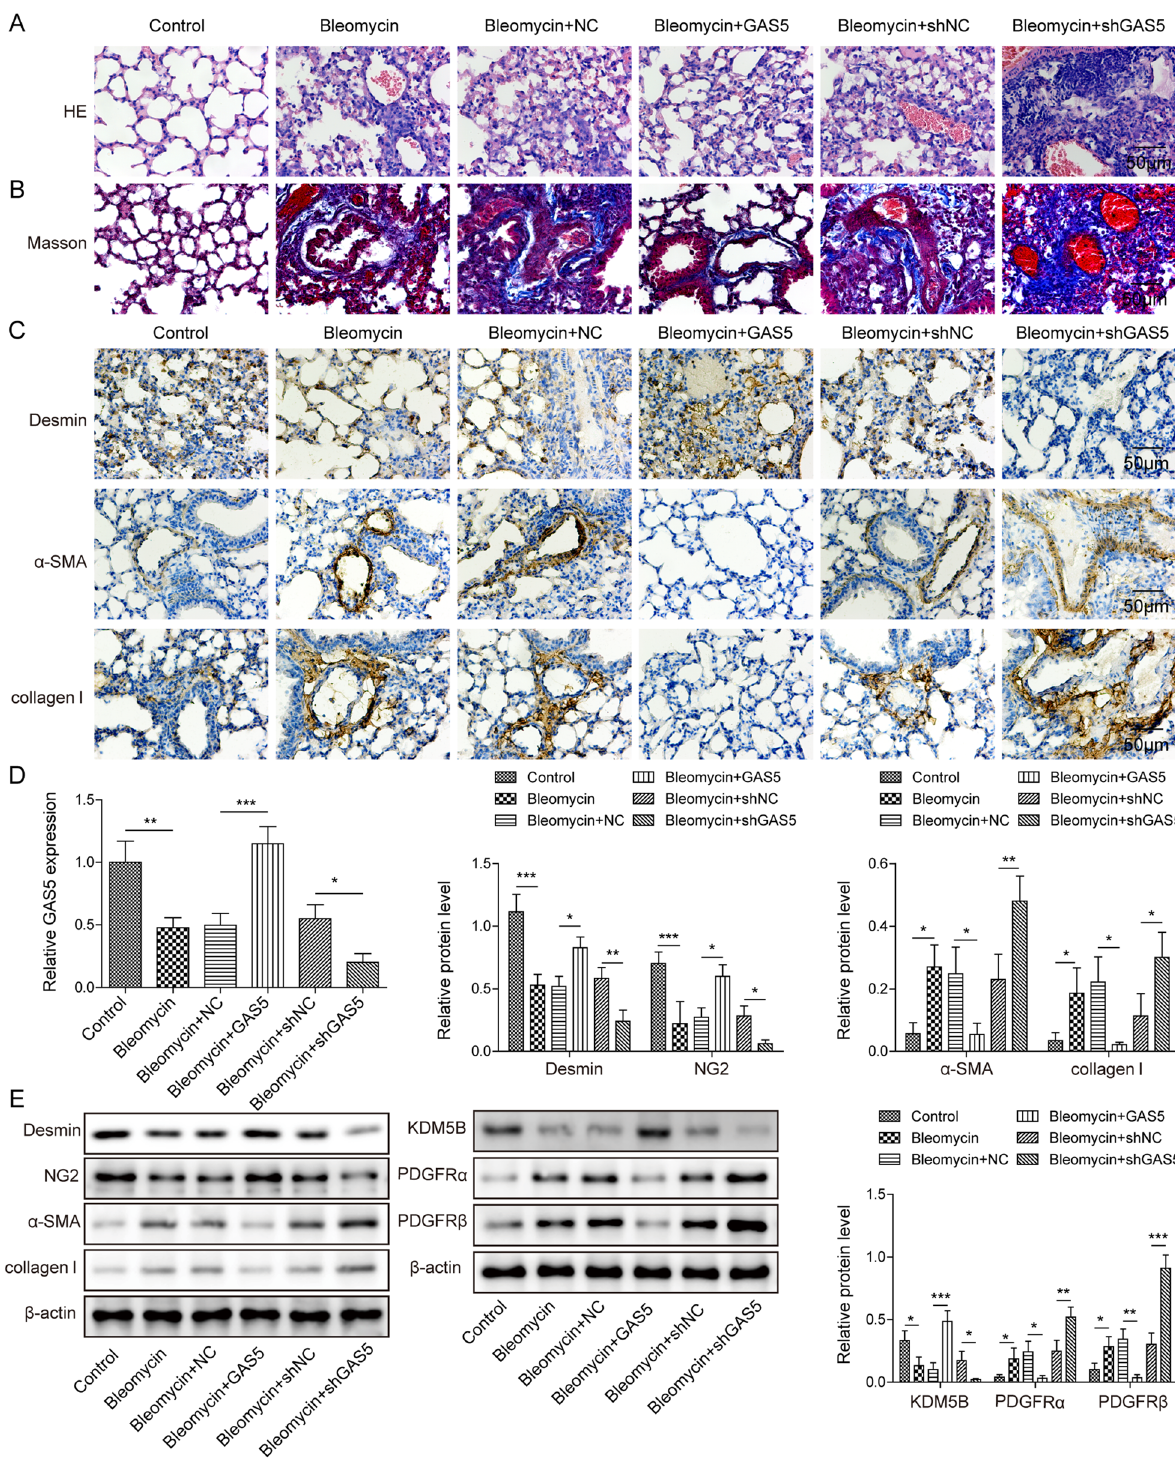
Fig. 8 GAS5 inhibited pulmonary fibrosis in the mouse model of pulmonary fibrosis in vivo. There were six experimental groups: control, bleomycin, bleomycin NC, bleomycin GAS5, bleomycin shNC, and bleomycin shGAS5. A , B The degree of pulmonary fibrosis and collagen + + + + deposition in the lungs of mice was assessed via H&E and Masson staining. C The expressions of desmin, α-SMA, and collagen I in the lung tissues were determined via immunohistochemical staining. D RT-qPCR analysis of GAS5 expression in different groups. E The protein levels of desmin, NG-2, α-SMA, collagen I, KDM5B, and PDGFR α/β in the lungs were examined via Western blotting. For A–E,